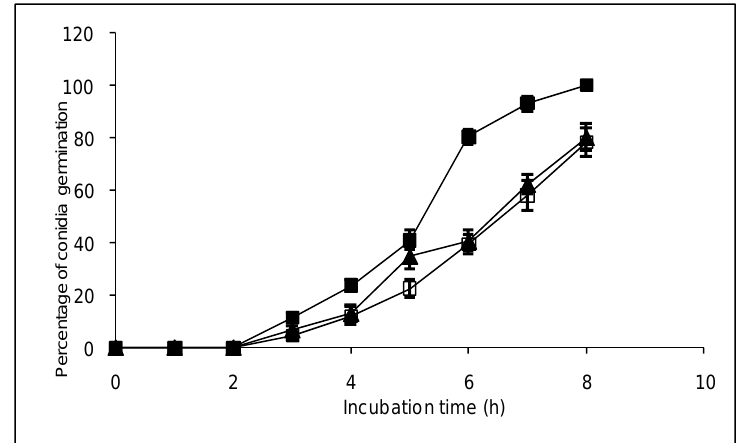
Figure 3 . Effect of compounds 1 and 2 on conidia germination of B. cinerea . Control